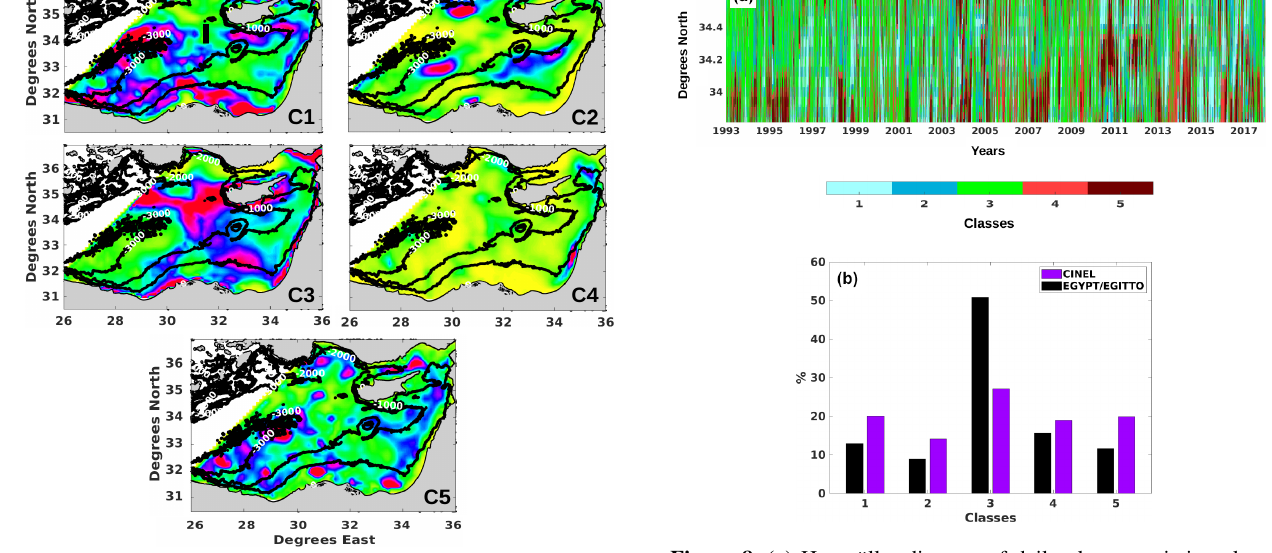
Figure 8. (a) Hovmöller diagram of daily cluster variation along the MMJ potential pathway at 31.5 ◦ E. The resulting cluster fre- quencies during the EGYPT/EGITTO (September 2005–July 2007) and CINEL campaigns (September 2016–August 2017) are shown in (b)